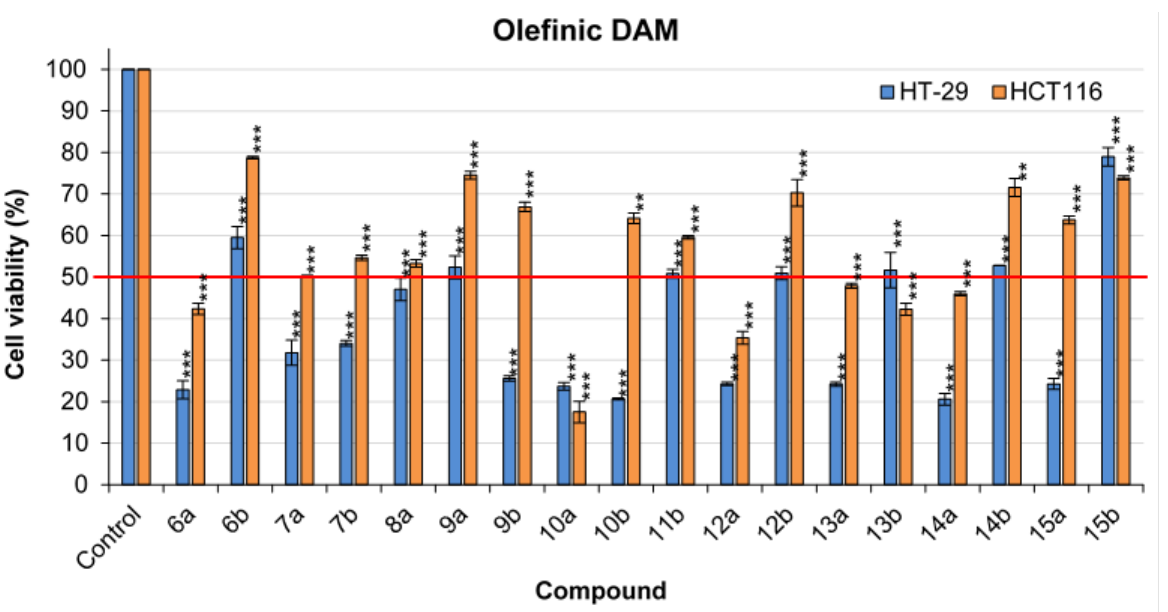
Figure 3. Screening of olefinic DAM series on human HT-29 and HCT116 CRC cell lines viability. Cell viability (%) after exposure to the DAM was measured by MTT assay. Compounds 6a-b, 7a-b, 8a, 9a-b, 10a-b, 11b, 12a-b, 13a-b, 14a-b, 15a-b were assayed at 50 μ M for 48 h. Each chart represents the mean percentage ± SEM from at least three independent experiments (n = 3). Cell viability lower than 50% was considered cytotoxic. ** p < 0.01 and *** p < 0.001 significantly different from the control.